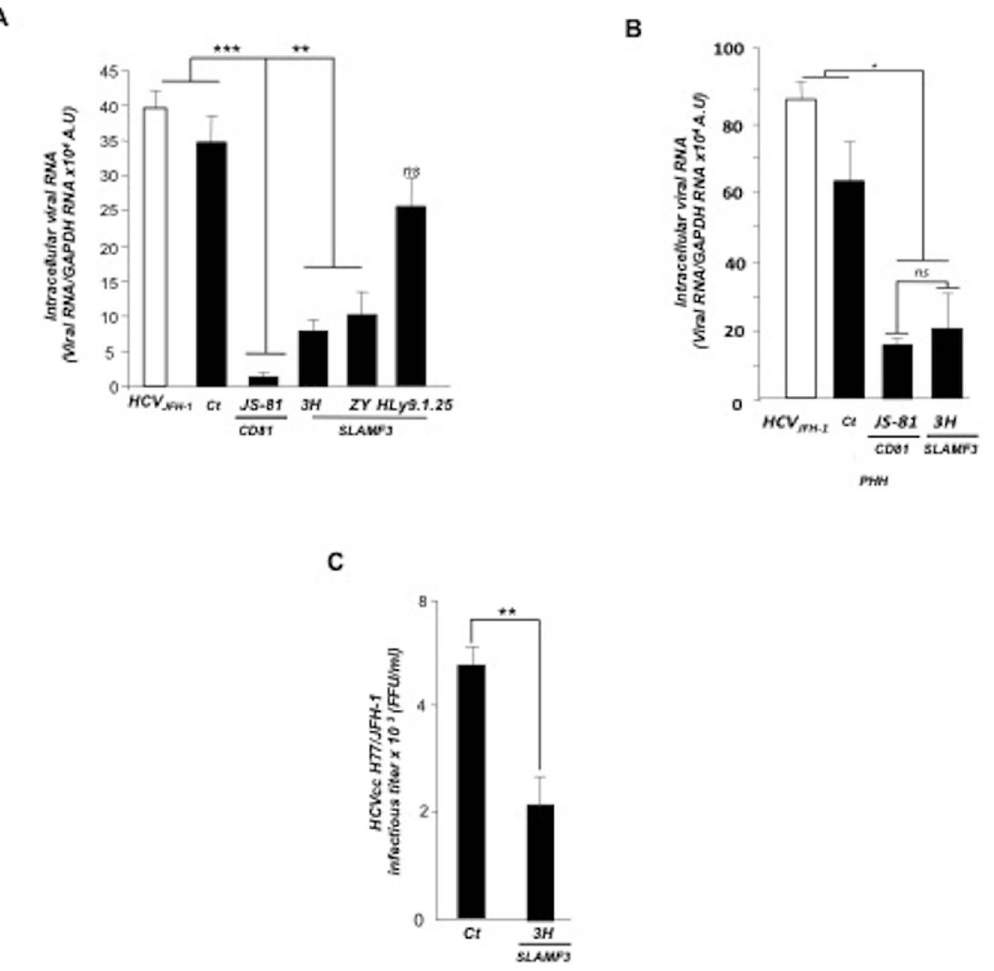
Figure 2. Antibodies against hepatocyte SLAMF3 reduce HCV infection. (A) Cells from the Huh-7 line were treated with anti-CD81 (JS-81) and/or anti-SLAMF3 (3H, ZY and HLy9.1.25 clones) mAbs prior to HCVcc infection (evaluated by quantification of intracellular vial RNA at 72 p.i.). (B) Cultured primary healthy human hepatocytes PHH were treated with anti-CD81 (JS-81) and/or anti-SLAMF3 (3H) mAbs prior to HCVcc infection (evaluated by quantification of intracellular viral RNA at 72 h p.i.). (Ct) refers to an isotype-matched control (in A and B), all neutralizing antibodies were used at 10 m g/ml; (C) The inhibitory effect of the 3H mAb on the number of FFUs after Huh-7 infection was checked at 72 h p.i. (mean of three independent experiments; error bars, SD * p , 0.05, **p , 0.01, ***p , 0.005, ns: